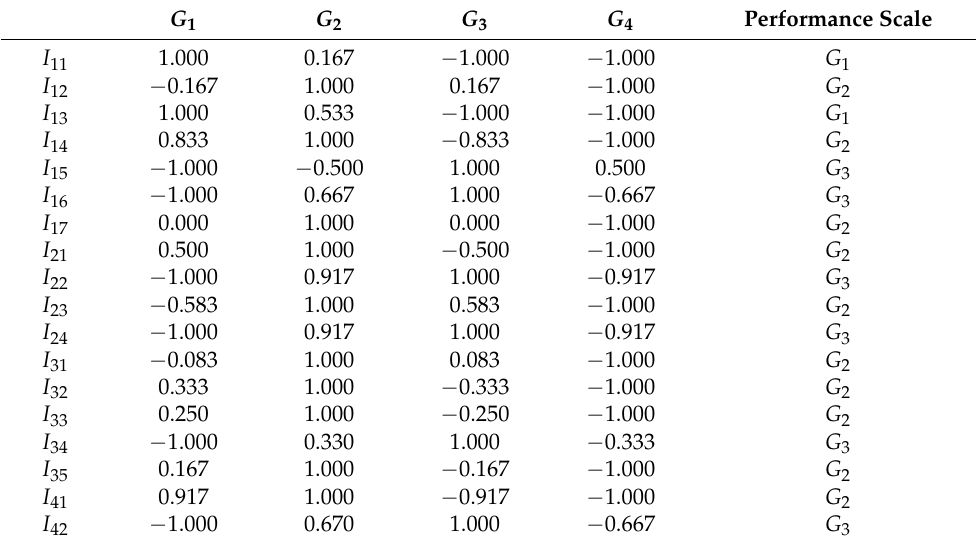
Table 8. The single-indicator connection degree of IM performance indicators.